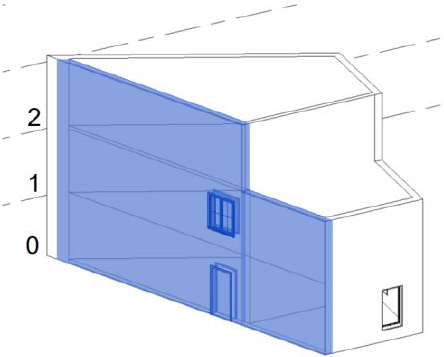
Figure 17. Visualization of the dataset A2 model with different floors utilized to create incomplete as-built models.